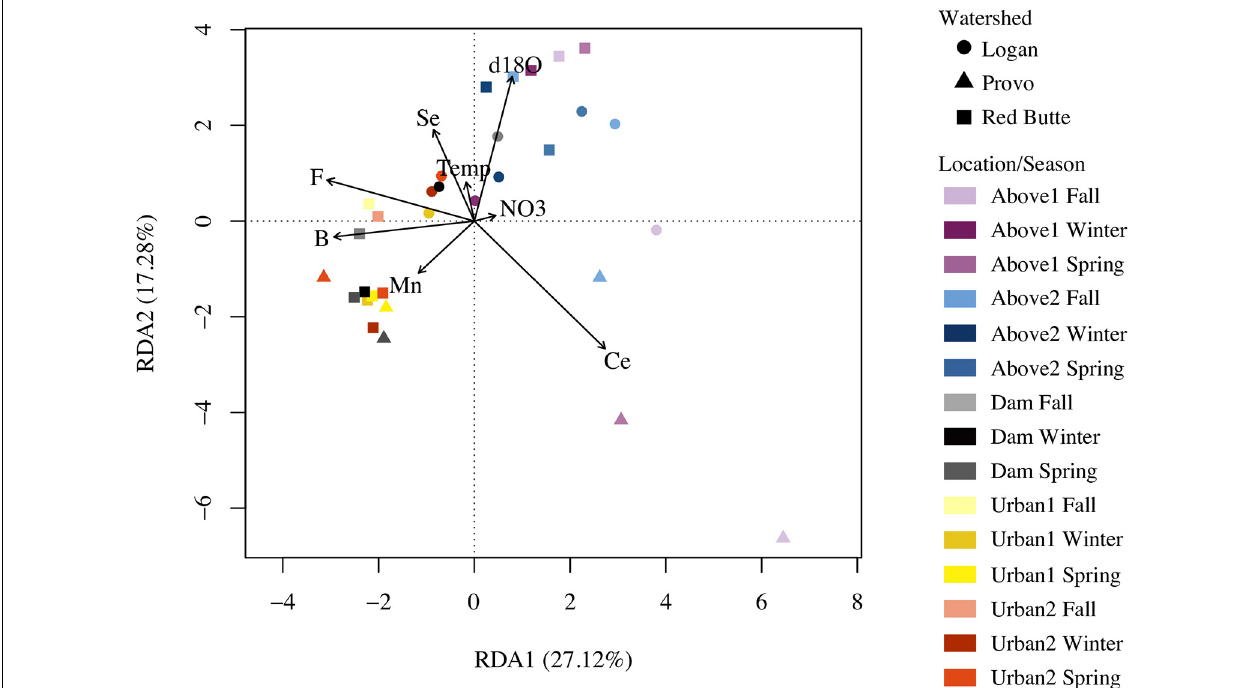
FIGURE 3 | Redundancy analysis (RDA) plot relating stream environmental variables and bacterial communities in streams in three Utah watersheds (Red Butte Creek, Provo River, and Logan River) across three seasons (Fall, Winter, and Spring). Vectors are significant environmental factors, indicating positive correlation. Location indicates position relative to man-made reservoirs and urban centers. Variables were selected from the combination of four RDA models of standard field parameters, nutrients, major ions, and trace elements ( Table 3 ).